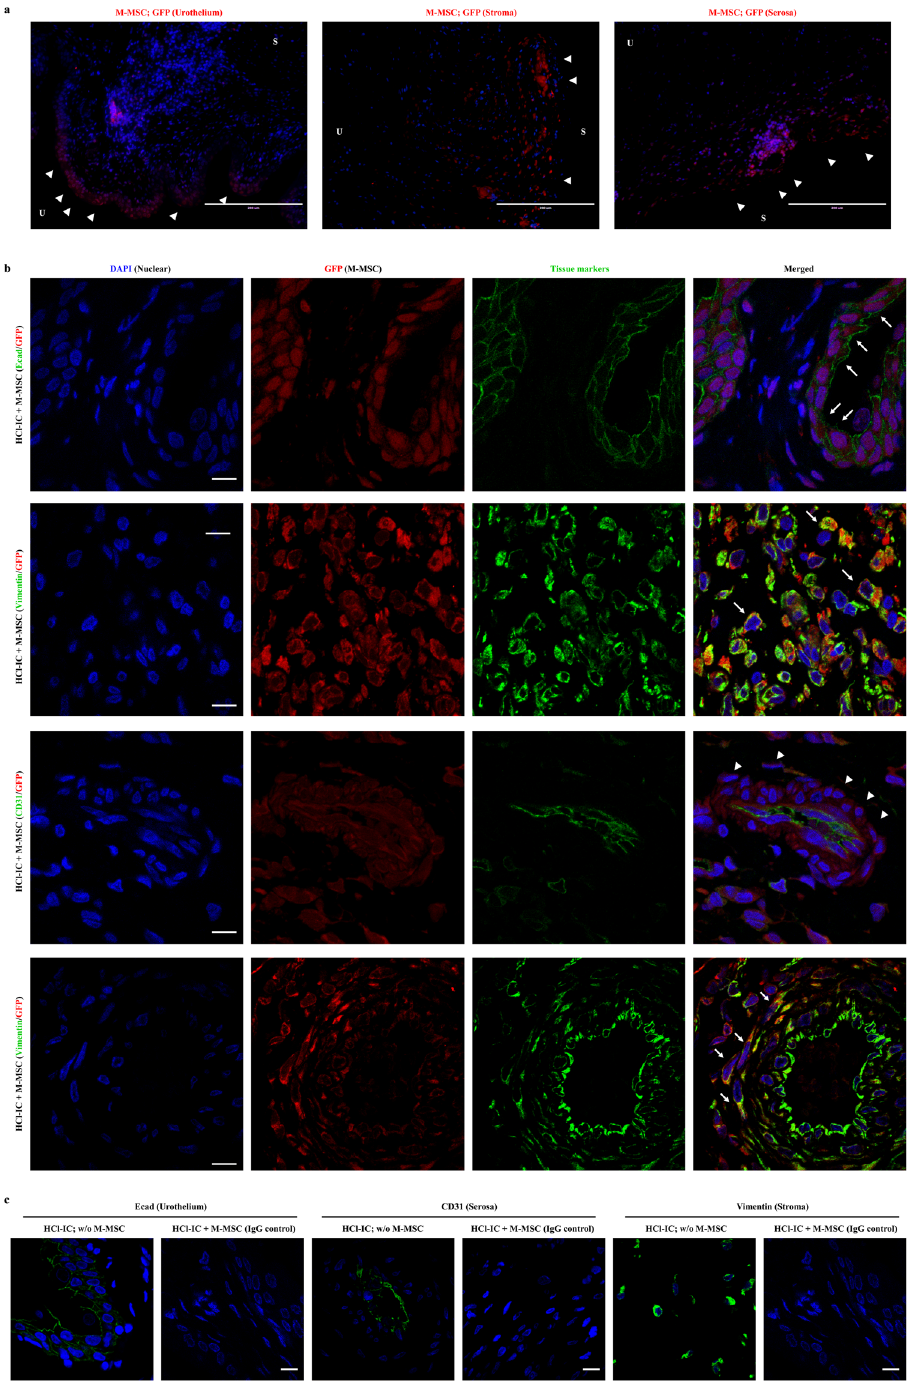
Figure 7. Immunostaining analysis for cellular properties of transplanted M-MSCs. ( a ) Detection of M-MSCs stably expressing GFP (red) in HCl-IC rat bladders at 7 DAT by immuostaining (magnification × 200, scale bar = 200 μ m). ( b ) Representative confocal micrographs of bladder sections transplanted with GFP-MSC (HCl-IC + M-MSC) after double staining for GFP + cells (red) and for E-cadherin (Ecad) + urothelial cells, vimentin + stromal and perivascular cells, CD31 + endothelial cells (green) (magnification × 1,000, scale bar = 10 μ m). Nuclei were stained with DAPI (blue). Arrow heads and arrows indicate the engrafted and differentiated cells, respectively. U; Urothelium, S; Serosa. ( c ) For negative control experiments, co-staining of bladders tissues in HCl-IC + M-MSC group animals with mouse and rabbit IgG control antibodies or co-staining of the indicated tissue markers (green) and GFP (red) in bladder tissues not-injected with GFP + M-MSCs (HCl-IC; w/o M-MSC) for corresponding tissue markers were included (magnification × 1,000, scale bar = 10 μ